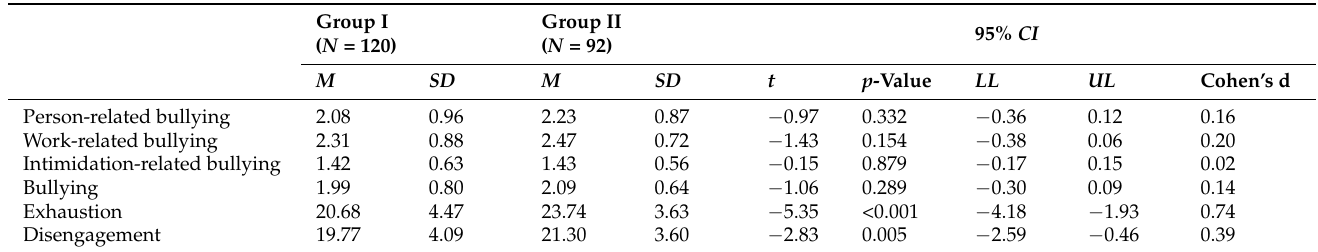
Table 2. Comparison of bullying and burnout between Group I and Group